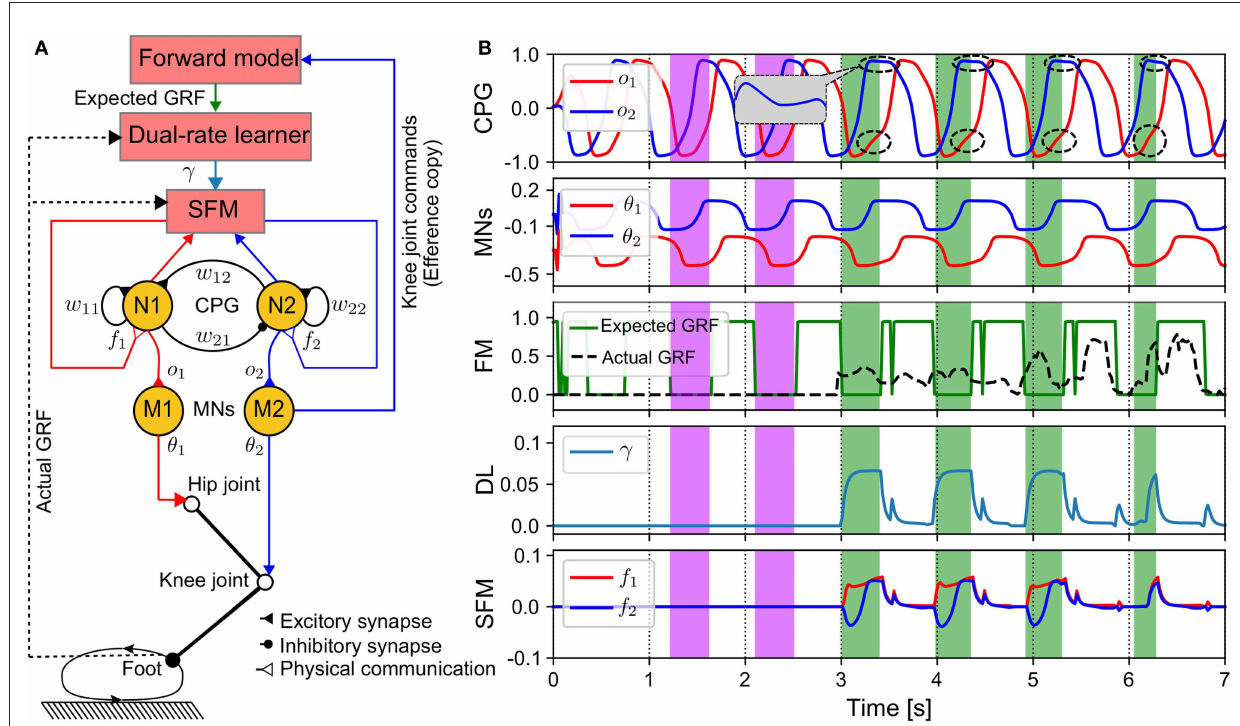
FIGURE2 APC mechanism of one leg. (A) Diagram of components realizing the APC. The DL can produce the adaptive gain depending on the error between the actual and expected GRF signals. The expected GRF signal is obtained from the forward model, which translates the motor command of the knee joint (efference copy) into the expected foot state (swing or stance state). (B) Outputs of the components. The purple and green color areas show initial (no adaptation) and strongly adaptation periods, respectively. The abrupt changes of the expected GRF at around 3.5 s, 4.5 s, 5.5 s to 0.0 are due to a brief ascending of the CPG output during the expected descending periods. The control parameters used in this test are listed in Supplementary Table S2. In this investigation, the SFM is activated to adaptively modulate the CPGs after 3 s and the stable gait is formed within 3–4